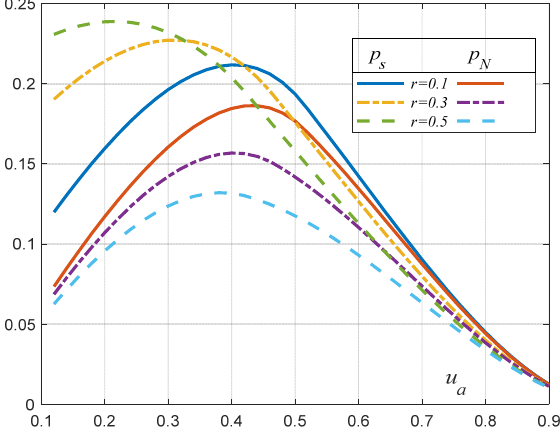
Figure 11. Dimensionless active powers: circuit and nonlinear load as a function of nonlinear load voltage amplitude and resistance.